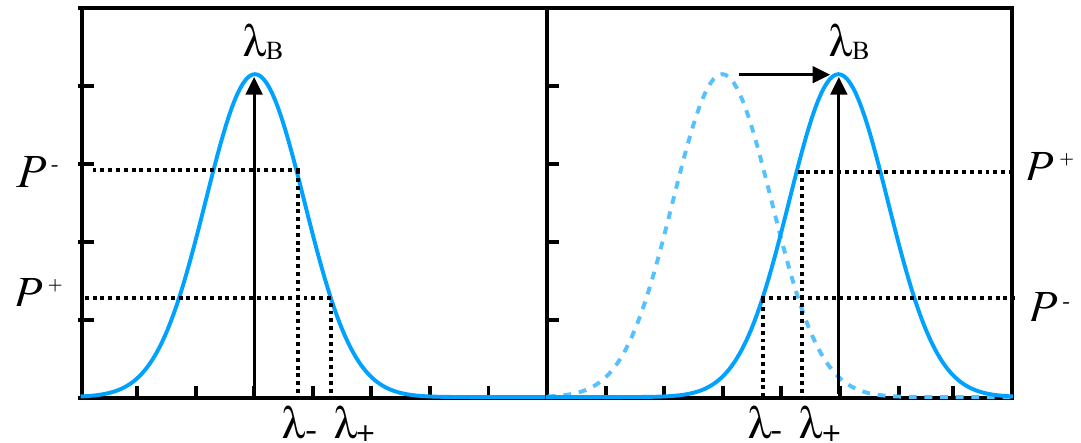
Figure 1. Dual-wavelength differential detection (DWDD) scheme involving the measurement of the reflected power at two closely spaced wavelengths λ + and λ − . As λ B shifts, the difference between the two reflected powers also